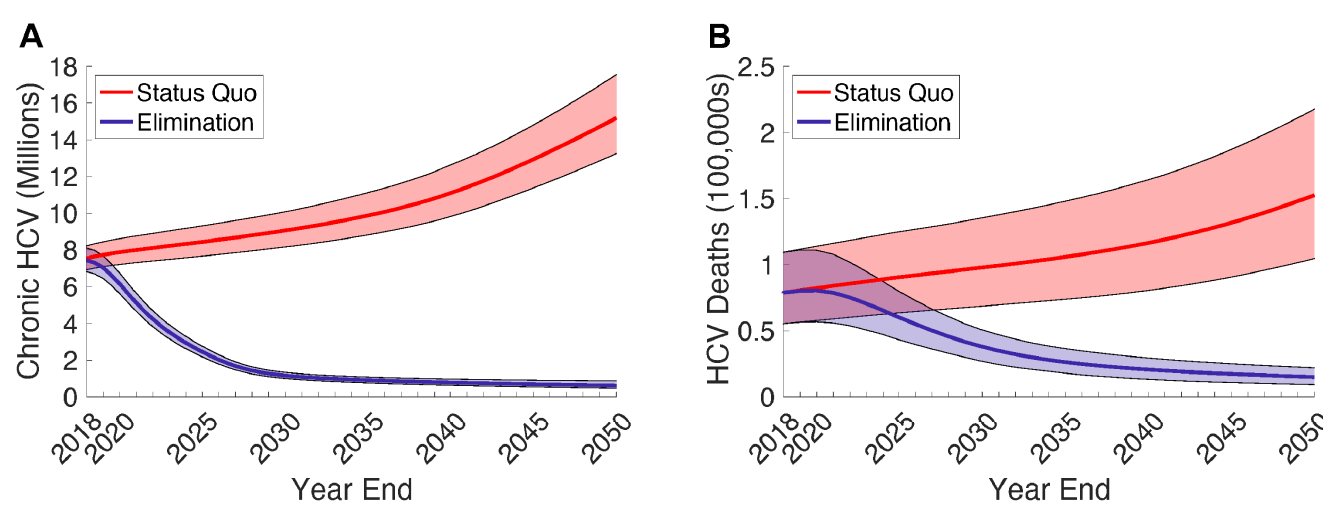
Fig 1. Estimated health impact of the SQ and EL scenarios on (A) the projected number of people living with hepatitis C and (B) the number of annual hepatitis C– related deaths. The solid line and shading indicate the median and 95% UIs across 1,151 model fits. EL, elimination; HCV, hepatitis C virus; SQ, status quo; UI, uncertainty interval.